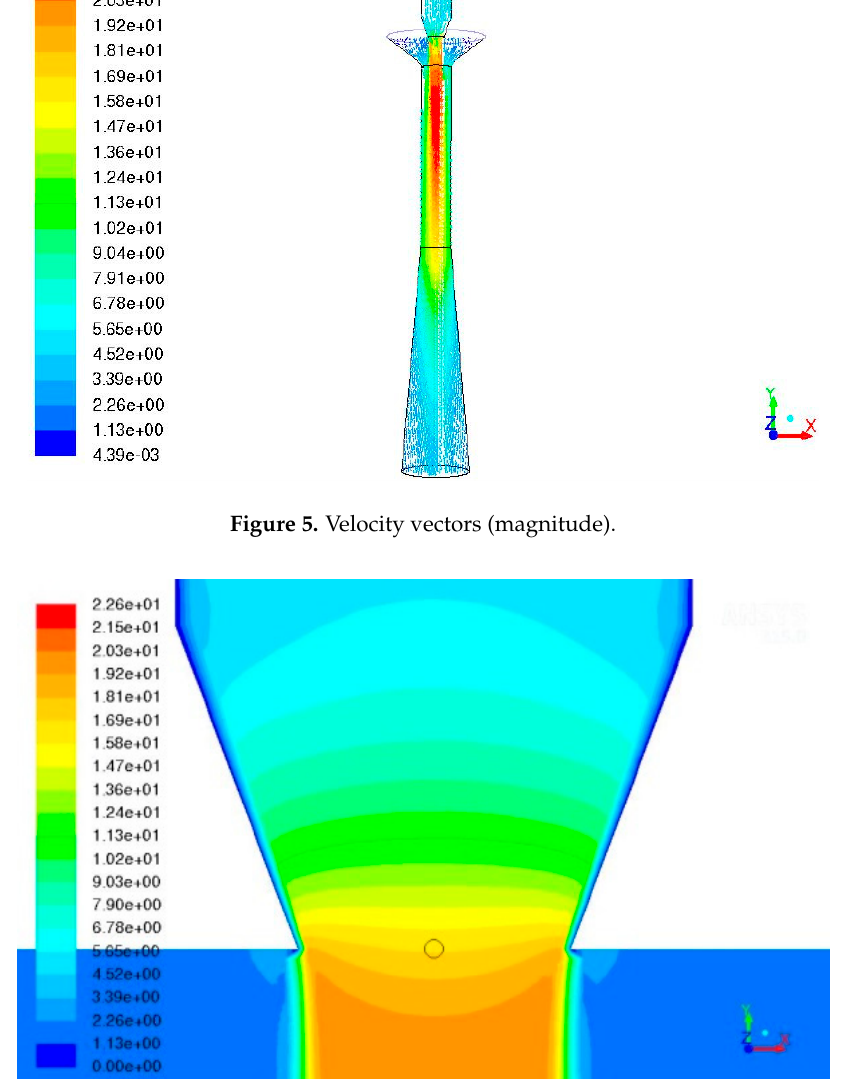
Figure 6. Contours of nozzle velocity (magnitude).